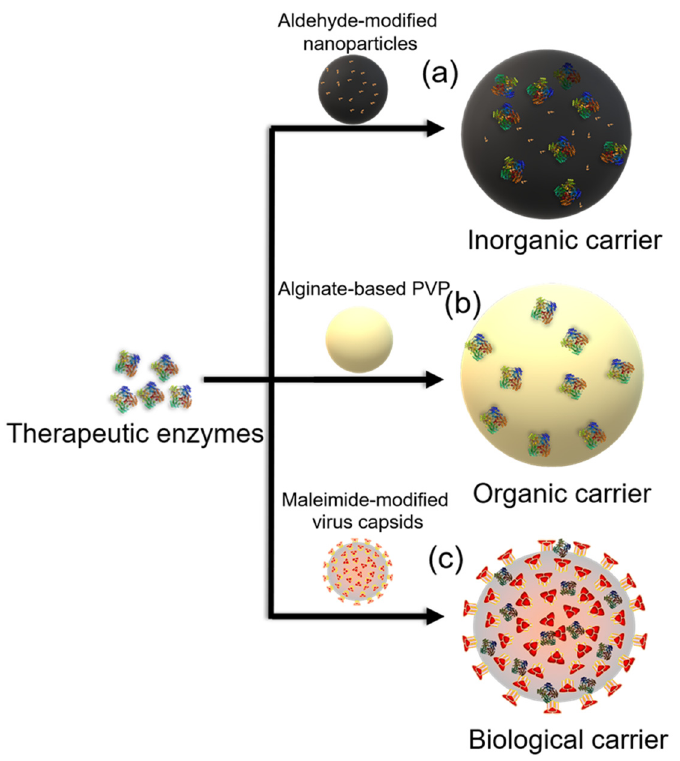
Figure 3. Illustration of adsorption approaches for therapeutic enzyme immobilization on ( a ) silica nanoparticles, ( b ) poly (N-vinyl-2 pyrrolidone) (PVP) microspheres, and ( c ) virus capsids.